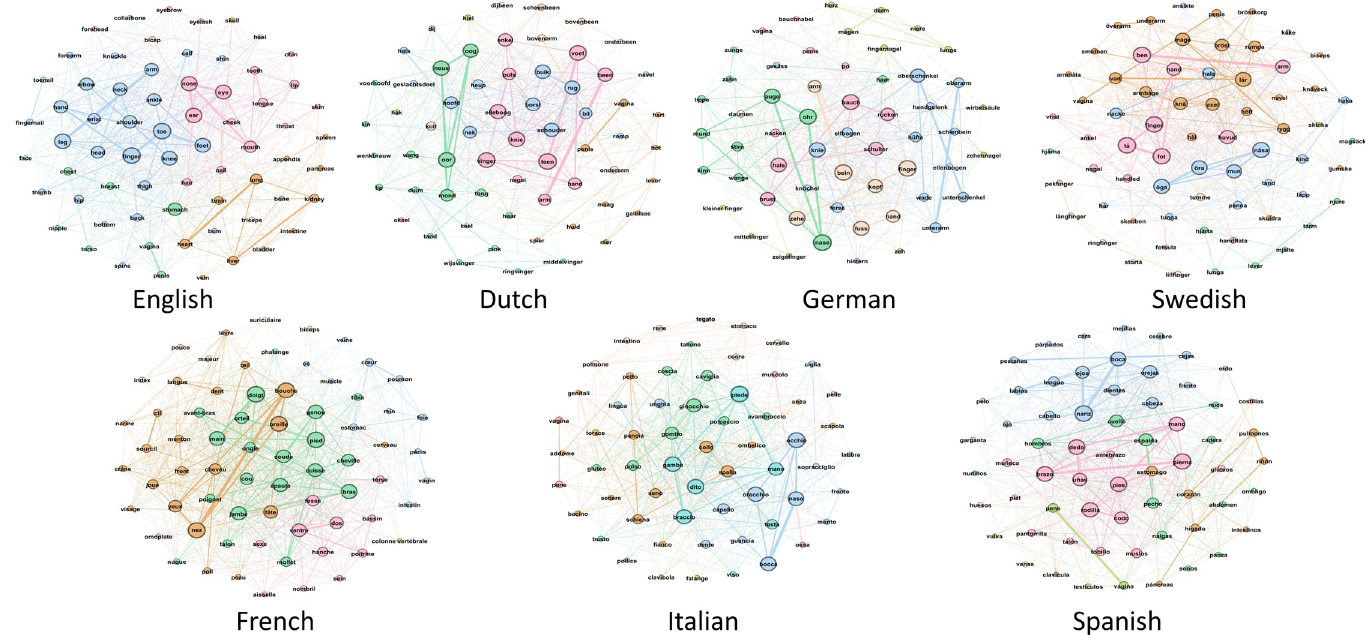
Fig 6. Core body part concepts across seven languages. Nodes indicate terms, links indicate co-occurrence, and colours indicate clusters within each language.